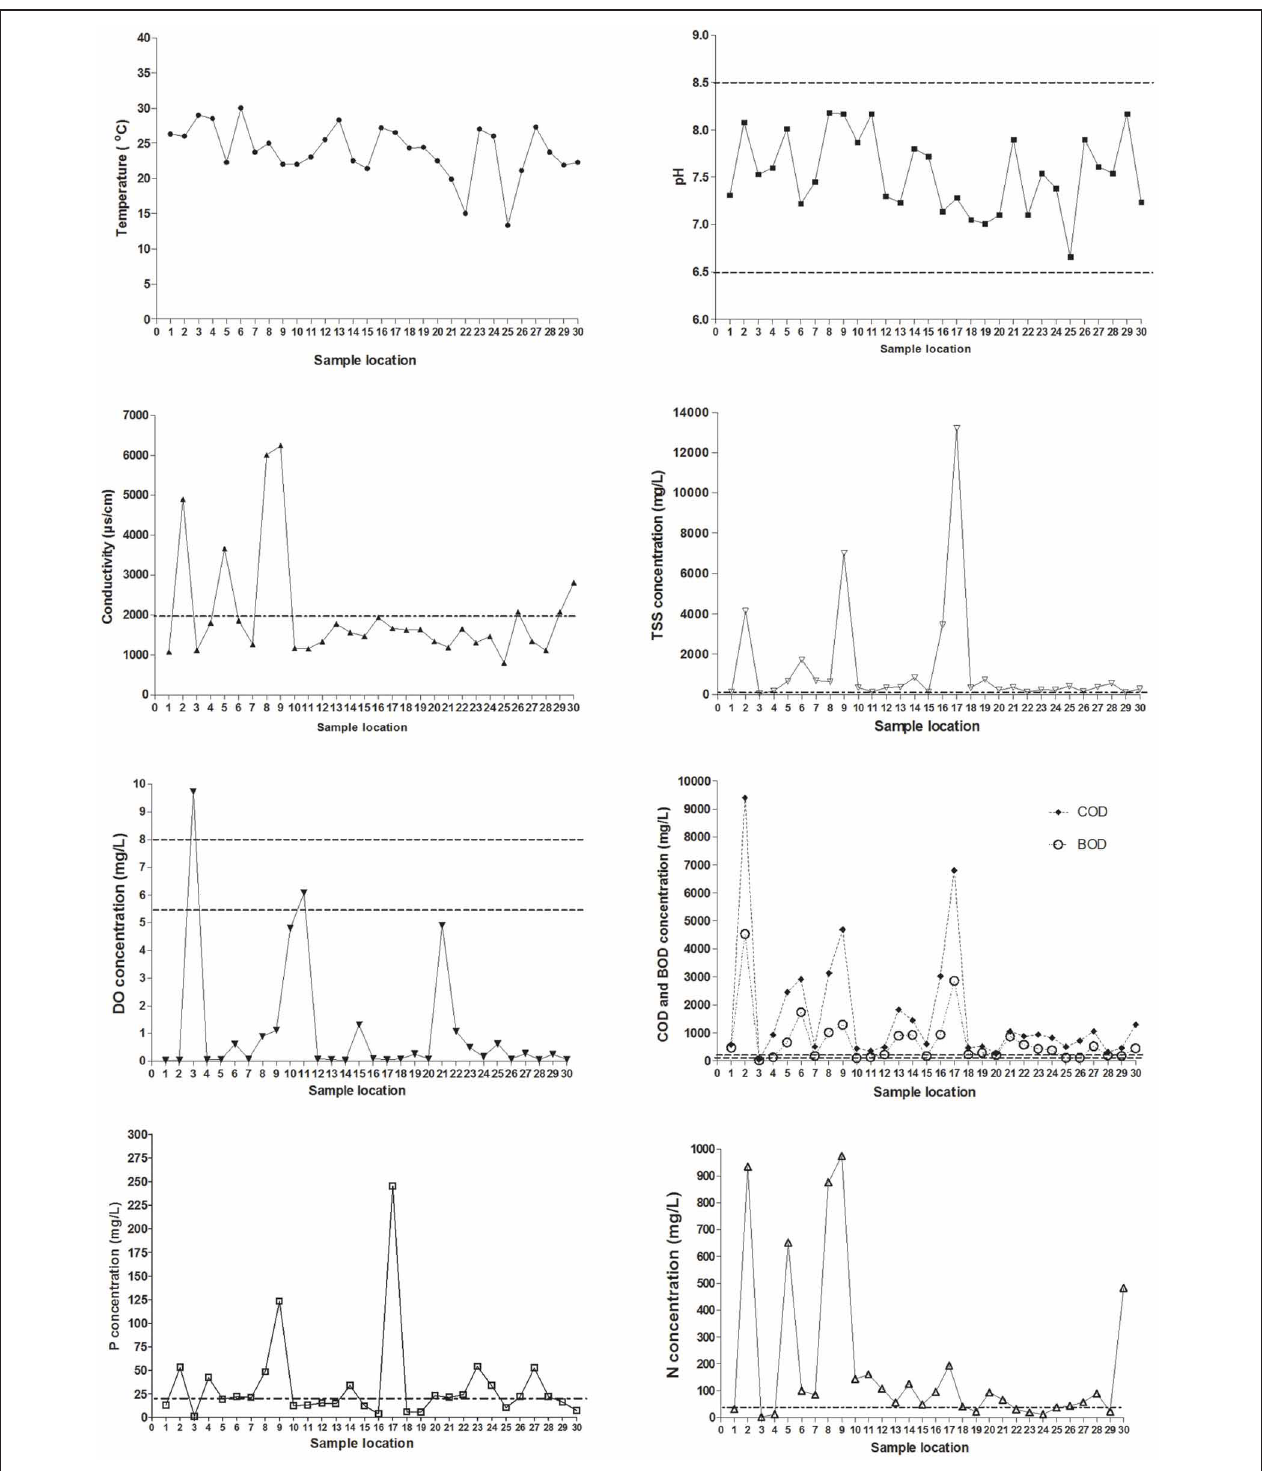
FIGURE 2 | Spatial variation of physico-chemical parameters from sampling locations on the San Pedro River. Permissible maximum limits are shown in dotted lines. pH values between 6.5 and 8.5 units are considered as good quality in potable water (NOM-127-SSA1-1994). Conductivity values above 2000 μ S/cm are exceeding the permissible limits. Nitrogen values above 40mg/L are exceeding the permissible limits.